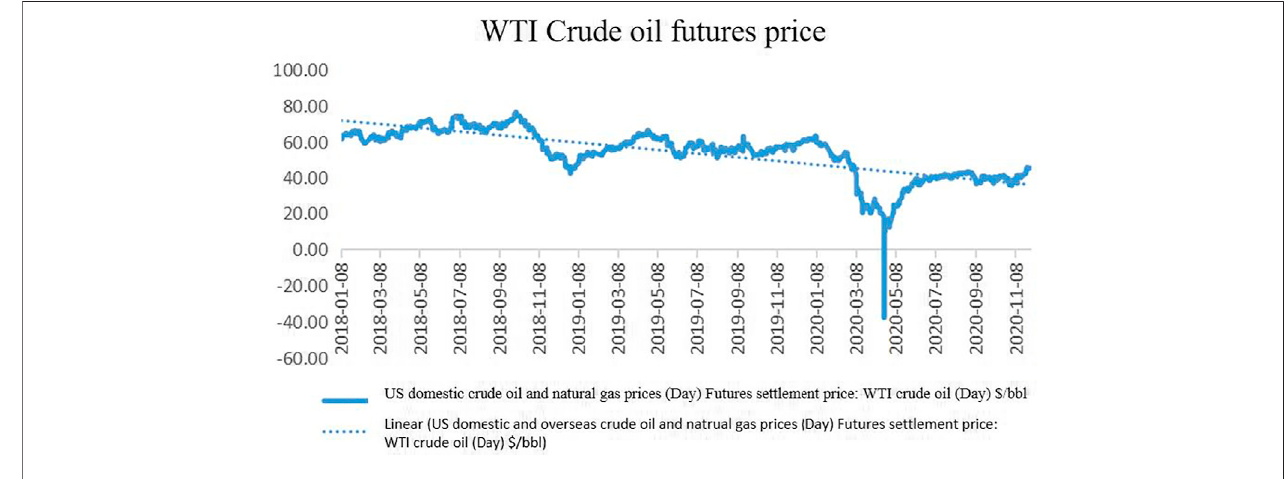
FIGURE 1 | WTI Crude oil future price (2018 – 2020).